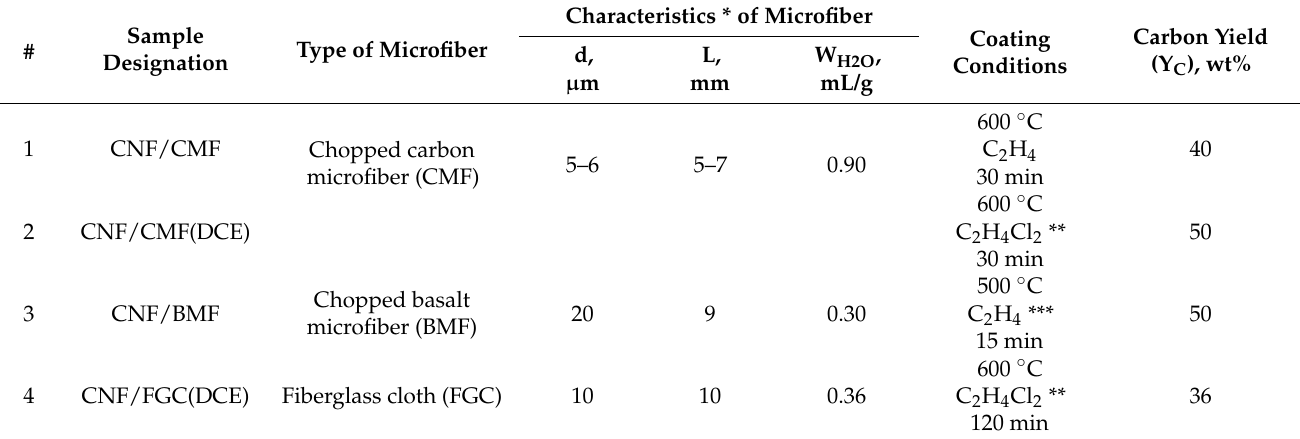
Table 1. Designation of the hierarchical samples and the conditions of their synthesis. Note that all samples were preliminarily reduced in hydrogen prior to contact with the corresponding reaction